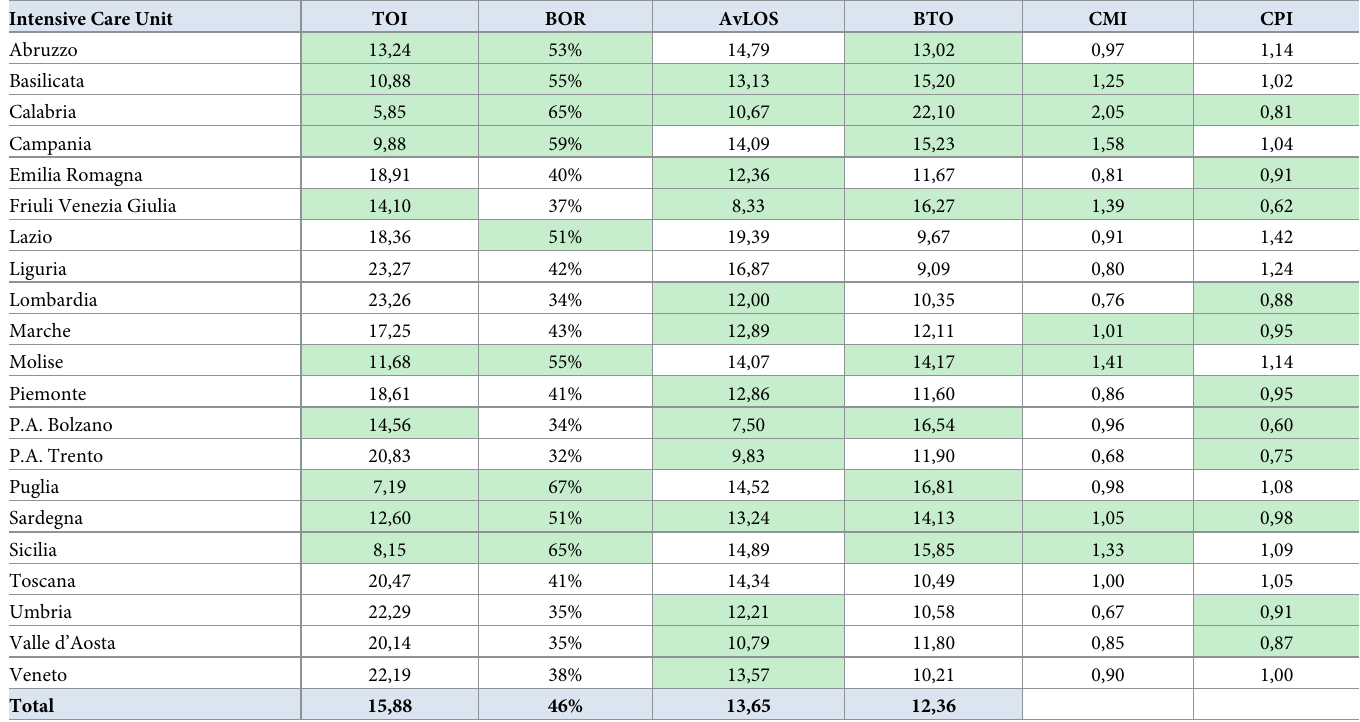
Table 5. Cross-regional comparison of the results of bed management as well as complex and performance analysis of intensive care units. Intensive Care